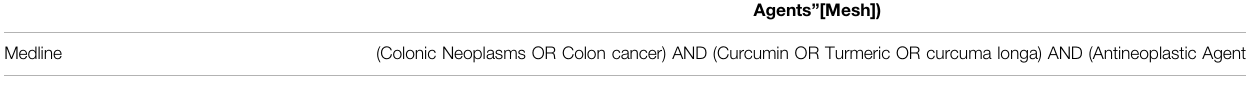
TABLE 1 | Search terms generated in each database PubMed